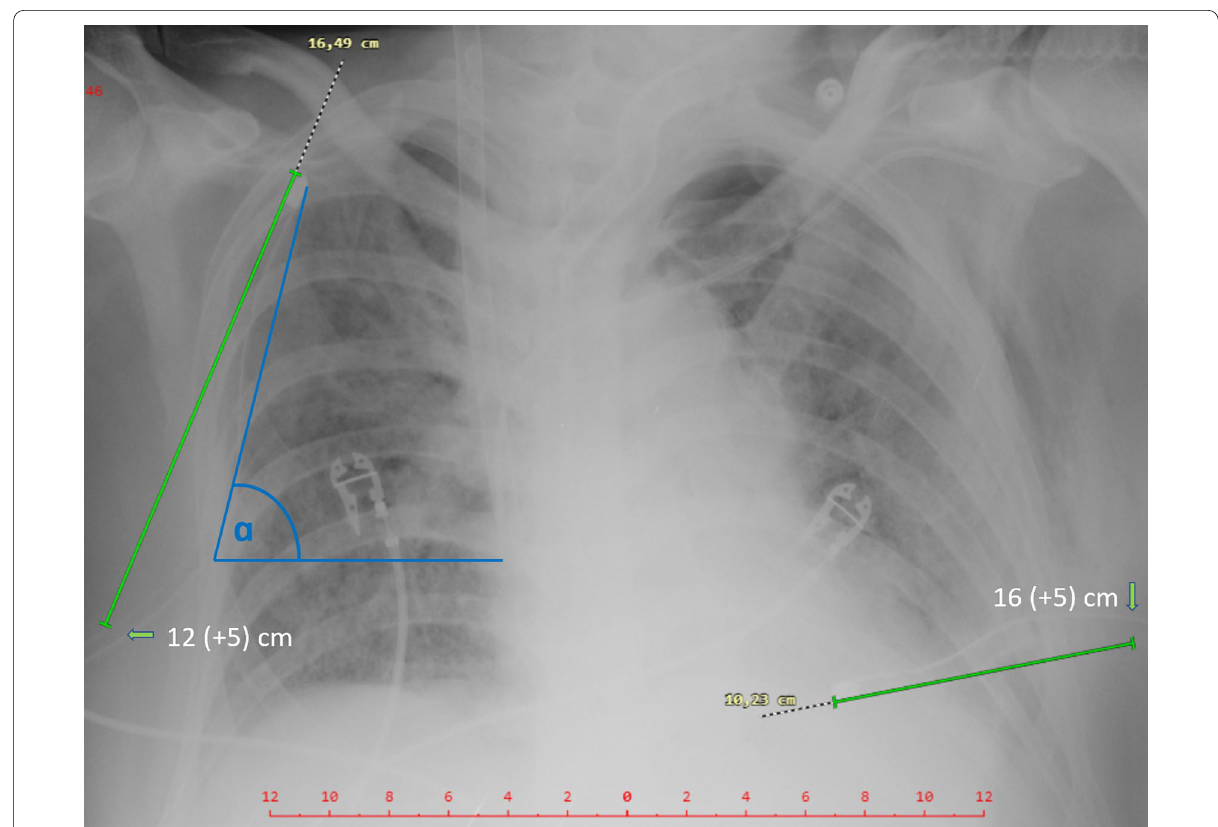
Fig.2 Patient on VV-ECMO with bilateral pneumothoraces has a steep ascending right CD ( ɑ ˃ 50°) with a CDI of 0.97 (16.49/12 pneumothorax on CUS of the right hemothorax. The left CD has a CDI of 0.49 (10.23/16 ventral pneumothorax on CUS (Fig.